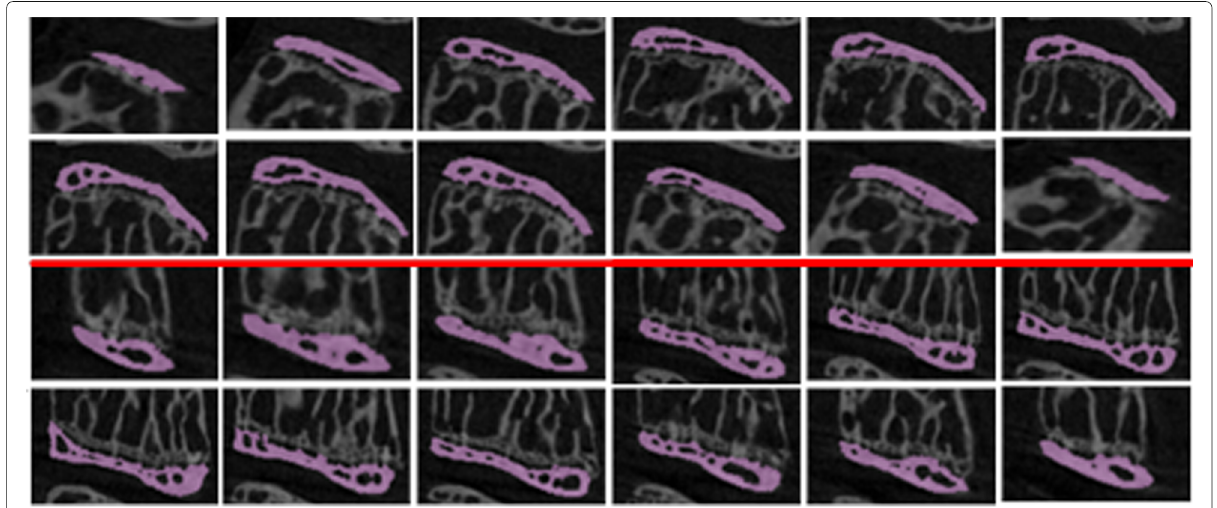
Fig. 12 The segmentation results in terms of 2D slices. The proposed method is employed to a randomly selected vertebra, the color regions of the 12 slices in the first, and second two rows are two endplates of the vertebra respectively